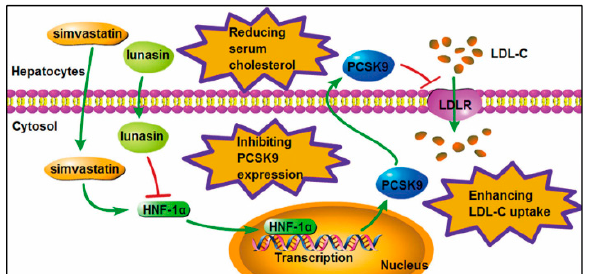
Figure 6. Schematic diagram of the molecular mechanism by which lunasin enhances the LDL-C lowering efficacy of simvastatin via down-regulating PCSK9 expression.